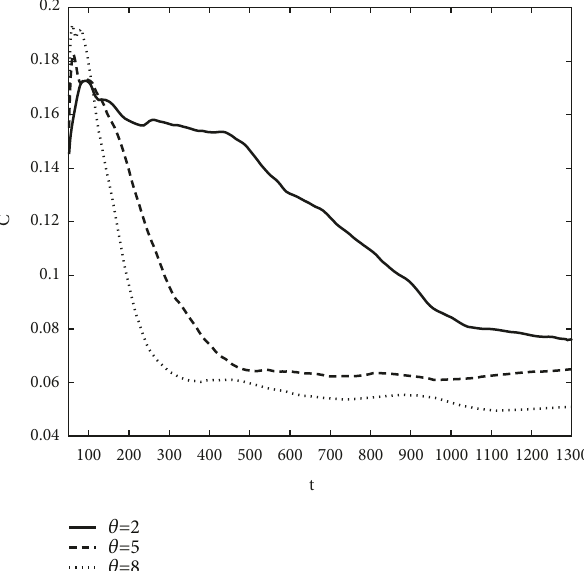
Figure 6: The evolution picture of the cluster innovation network average clustering coefficient.